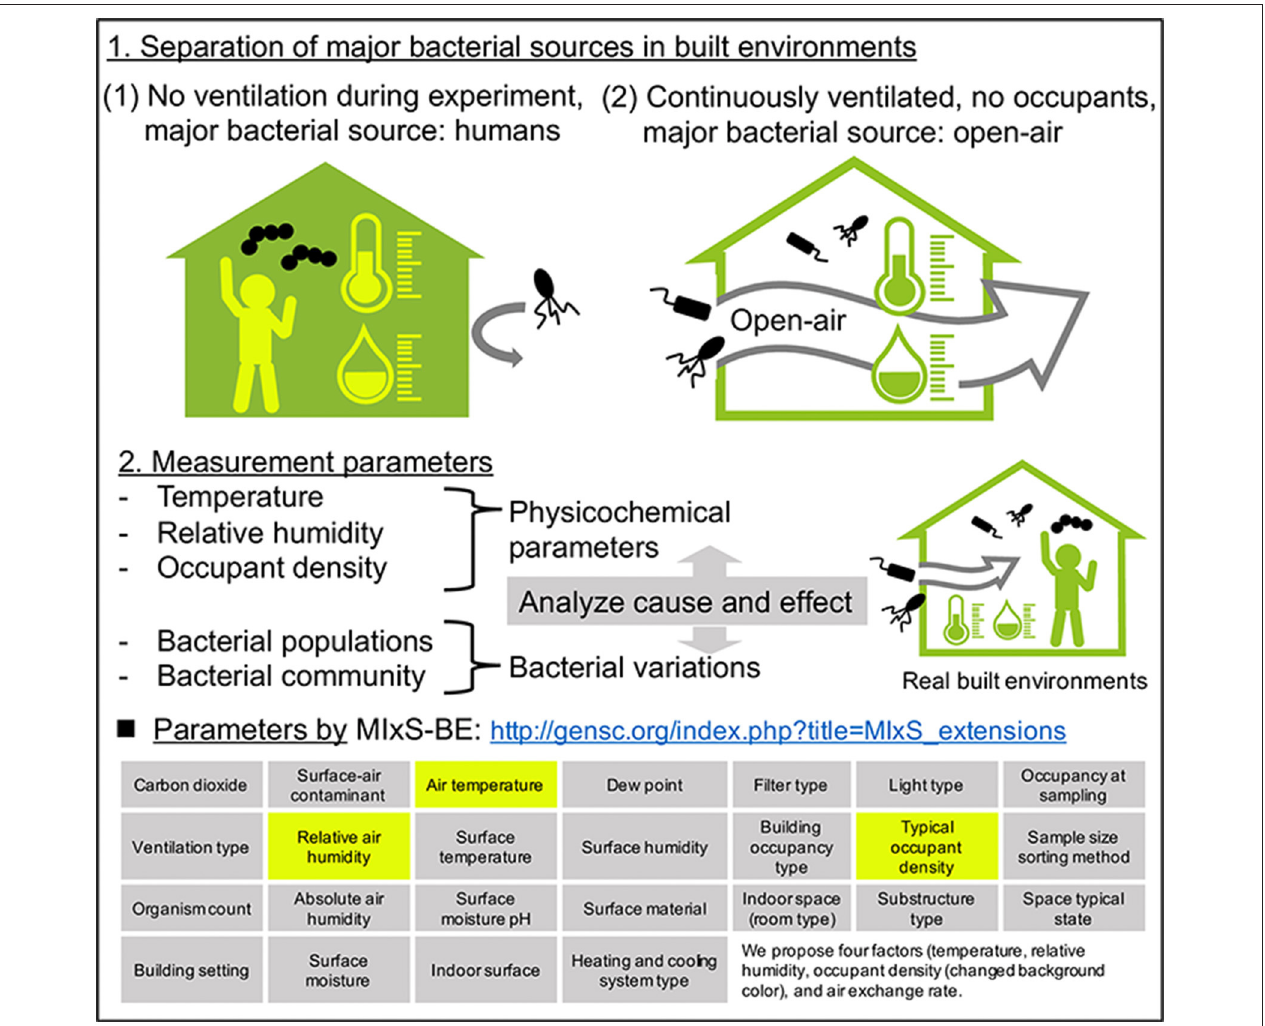
FIGURE 4 | A plan for analyzing the causal relationship between seasonal bacterial variations and physicochemical parameters in built environments. The four factors (temperature, relative humidity, occupant density, and air exchange rate) are the minimum requirement for monitoring that we